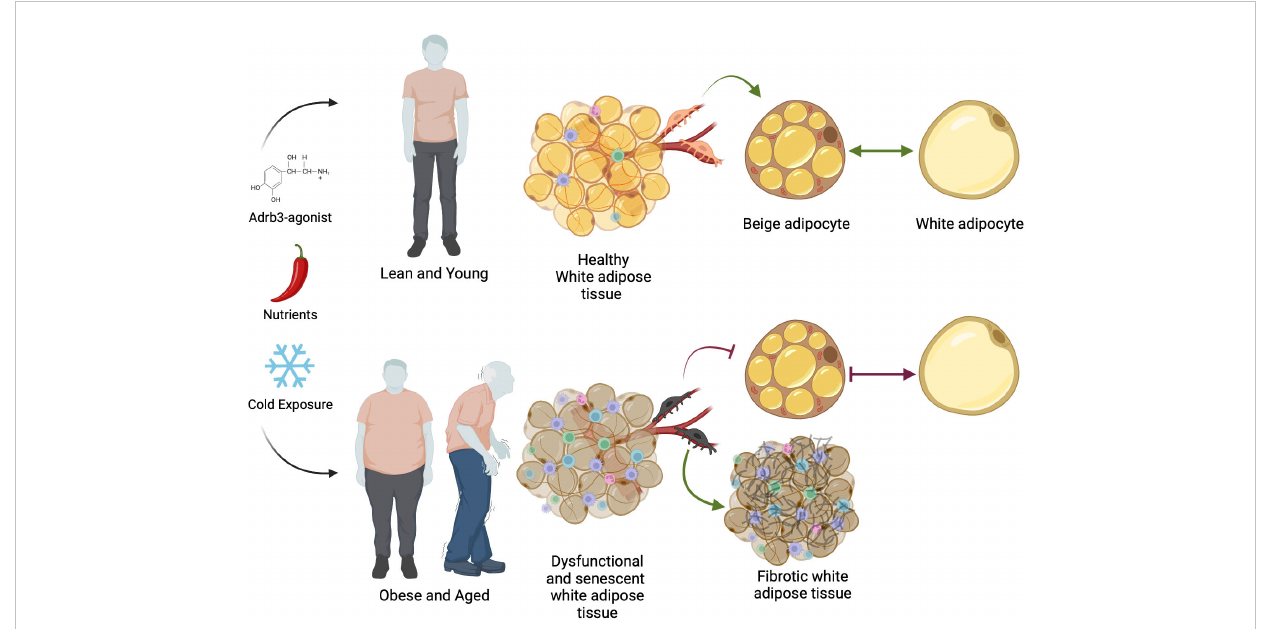
FIGURE 3 The decline in thermogenic fat biogenesis. Environmental, biochemical, and dietary activators can induce beige adipocyte formation in humans. In lean and young individuals, healthy white adipose tissue is freely able to perform beige-white adipocyte conversion depending on stimuli. In obese and aged settings, beige APCs become disrupted and display a senescent signature, becoming unresponsive to beige adipogenic stimuli. Moreover, changes in beige APCs facilitate fi brotic tissue replacement and in fl ammation. Additionally, aging is associated with changes in mitochondria function and thyroid hormone sensitivity resulting dysregulated white-to-beige interconversion. Together, age- and obese-associated changes in adipose tissue homeostasis sti fl e thermogenic fat biogenesis and metabolic protection. Illustration created with